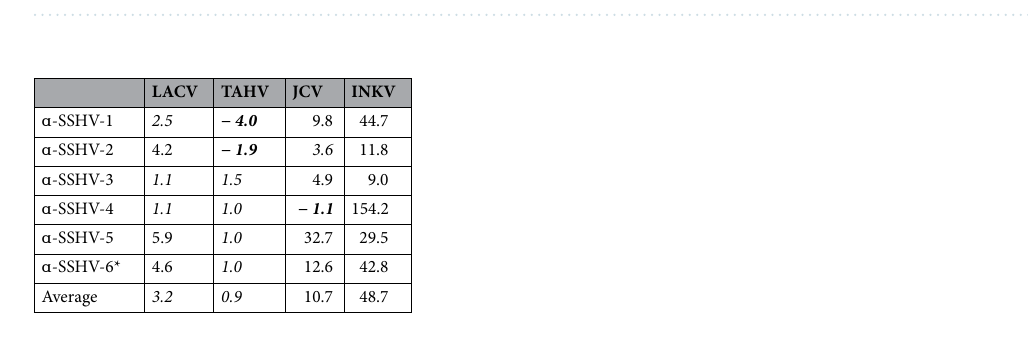
Table 4. ND50 fold difference of ɑ -SSHV plasma between heterologous viruses vs. homologous SSHV *Homologous ND50 > 6250, but 6250 highest dilution tested and value used. Italics = < fourfold difference. Bold = higher heterologous ND50.